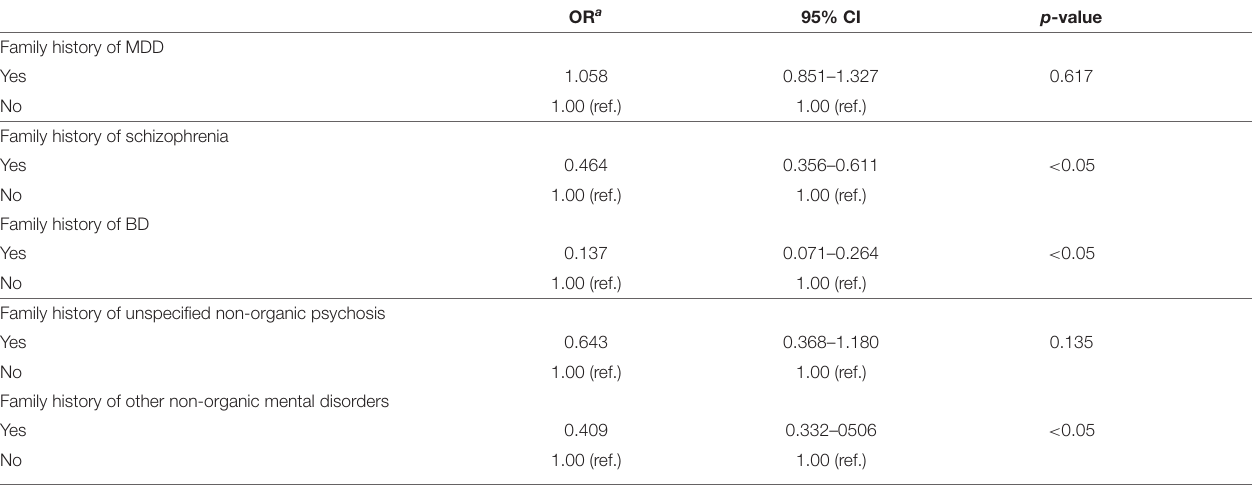
TABLE 3 | Risk of MDD as first diagnosis at admission presented as adjusted ORs grouped by family history of psychiatric